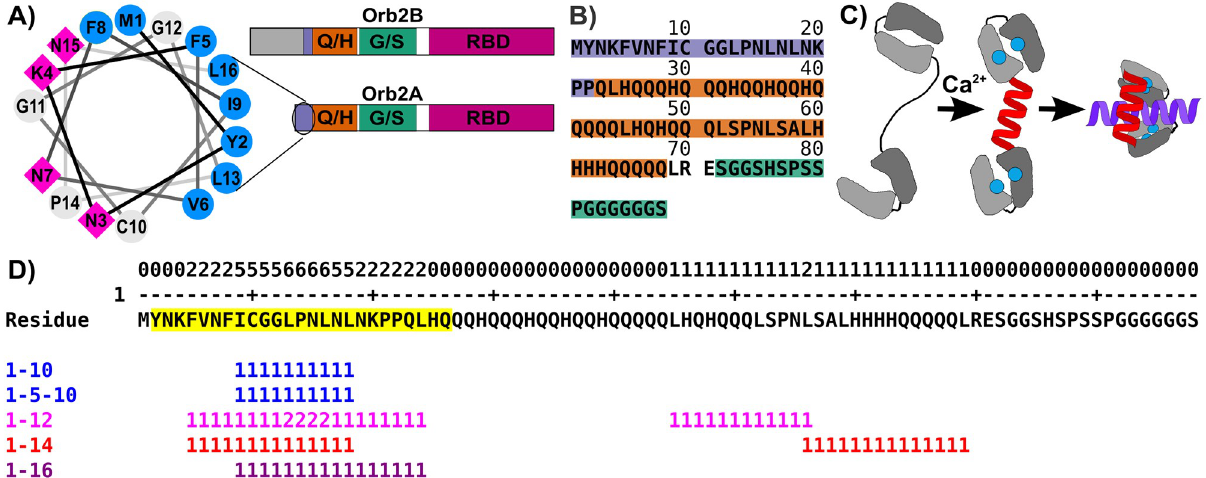
Fig 1. A) Domain layout of Orb2A and Orb2B, including the amphipathic helix at the N-terminus of Orb2A. The extended N-terminus of Orb2B is highlighted in gray, the amphipathic region in purple, the Q/H-rich domain in orange, the G/S-rich domain in green, and the RBD in pink. B) Sequence of the N-terminal 88 amino acids of Orb2A used throughout this study. The colors correspond to the domains in A. C) Mechanism by which Ca 2+ /CaM binds to amphipathic helices. Blue circles represent Ca 2+ , the red helix is the linker domain of CaM, the purple helix is a hypothetical CaM binding partner. D) CaM binding site prediction using the calmodulin meta-analysis predictor. Overall per residue score that is equal to the number of times a residue is found in a canonical CaM-binding motif is shown in the first line followed by the Orb2A 1-88 sequence with the identified potential binding motif highlighted in yellow. Matches to canonical CaM binding motifs are shown at the